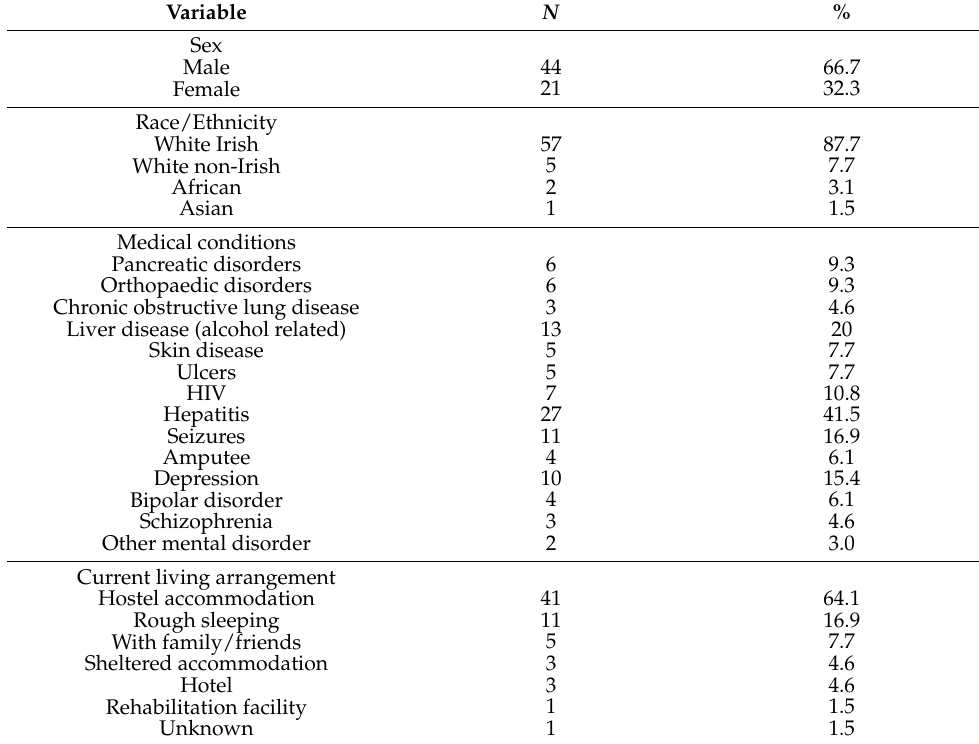
Table 2. Demographic characteristics of participants.